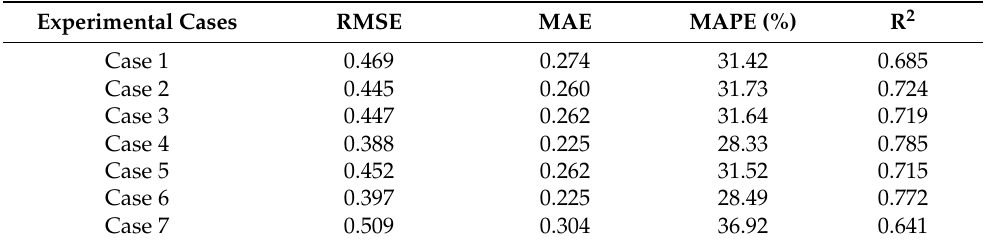
Table 5. Performance metrics associated with the LightGBM model-estimated ch1-a